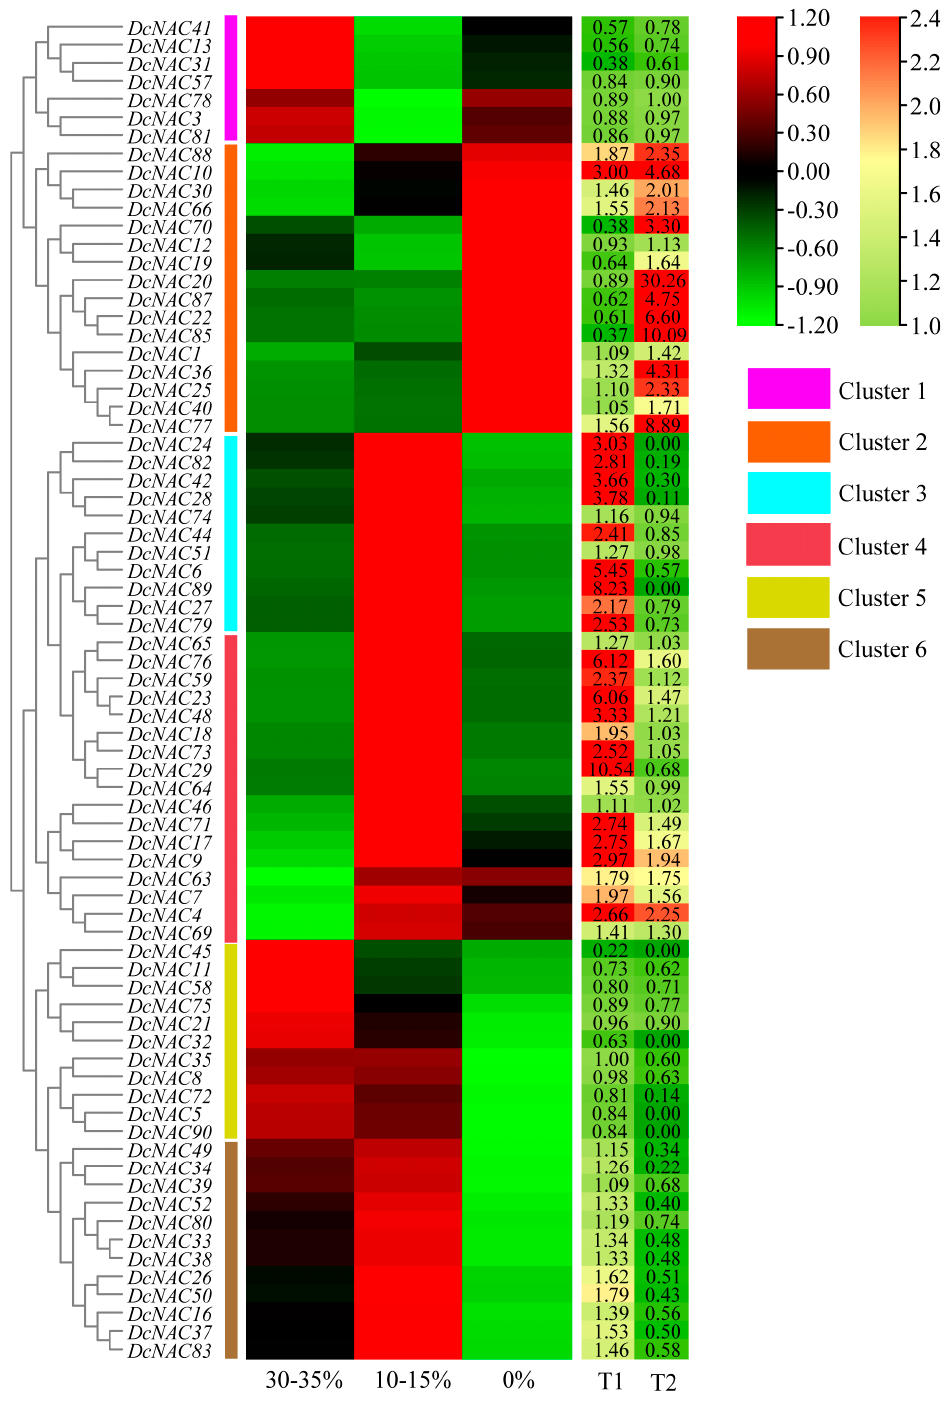
Figure 6. The expression patterns of DcNAC genes evaluated by RNA-seq. The left heatmap shows the expression of DcNAC genes under different volumetric water contents of base material. Data were normalized relative to each gene’s mean expression value across all treatments and log2-transformed. TPM (transcripts per million) values were used to create a heat map showing the expression of DcNAC genes. The expression level ranged from low expression (green) to high expression (red). The right heatmap showed the TPM ratios, with high ratios in red and low ratios in cyan. T1 was equal to the TPM of 10–15% divided by the TPM of 30–35%, and T2 was equal to the TPM of 0% divided by the TPM of 30–35%. The amounts of 30–35%/10–15%/0% represent the fact that the volumetric water content of the base material declined to ≈ 30–35%, ≈ 10–15%, and ≈ 0%,